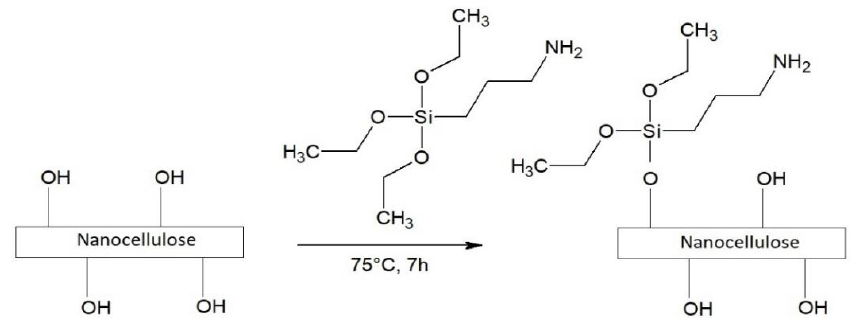
Figure 1. Schematic diagram of APTES-modified nanocellulose preparation.